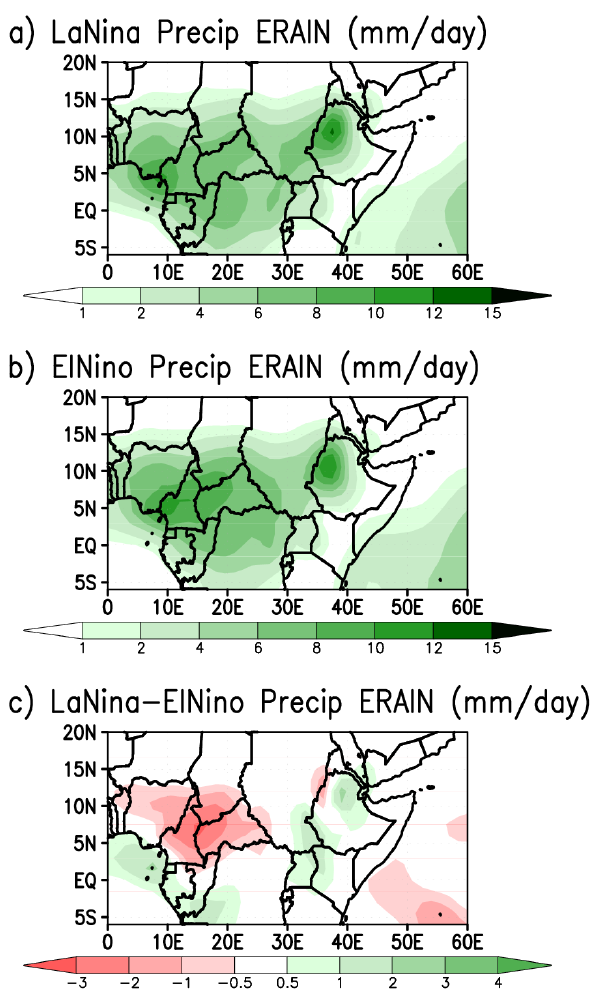
Figure 9. ERA Interim JJAS rainfall for (a) 5 La Niña years (1988, 1998, 1999, 2007 and 2008), (b) 5 El Niño years (1982, 1983, 1987, 1992 and 2002), and (c) the difference between La Niña years and El Niño years.